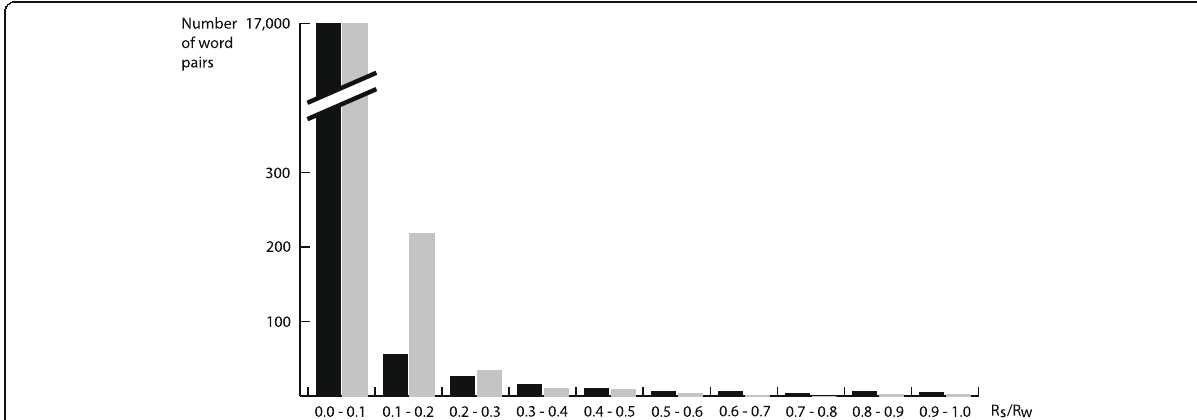
Fig. 14 Number of word pairs divided into classes of the relation values R S and R W of all word pairs generated in the first part of the study. The black bars represent R S values, and the gray bars represent R W values